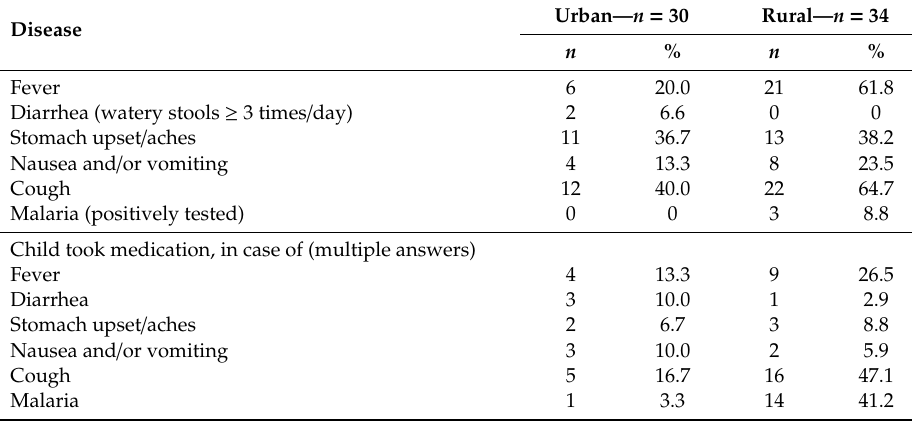
Table 3. History of diseases among schoolchildren in the month preceding the interview.